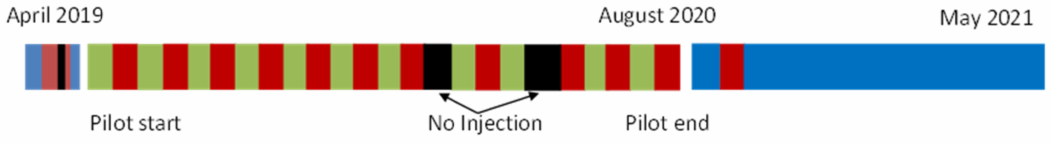
Figure 6. Injection overview of the radial model for East Seminole Field. Water injections (blue), CO 2 injections (red), surfactant injections (green), no injection periods (black).